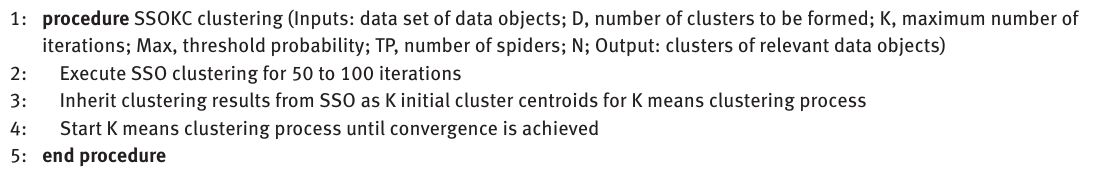
Algorithm 2: SSOKC clustering